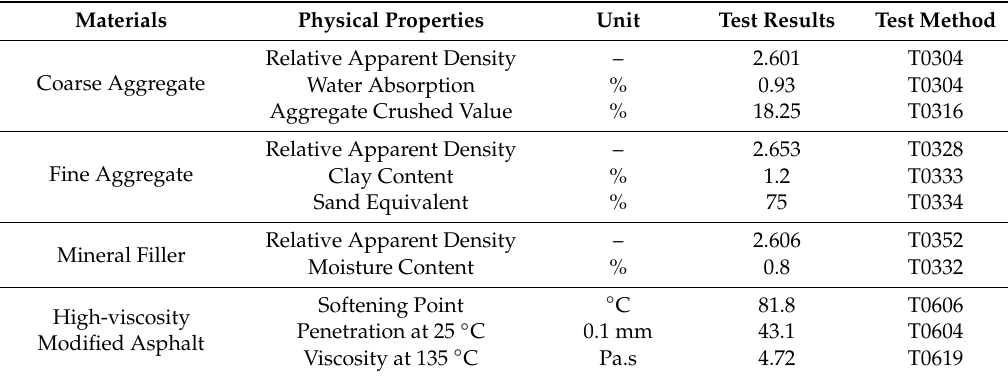
Table 2. Properties of the materials.